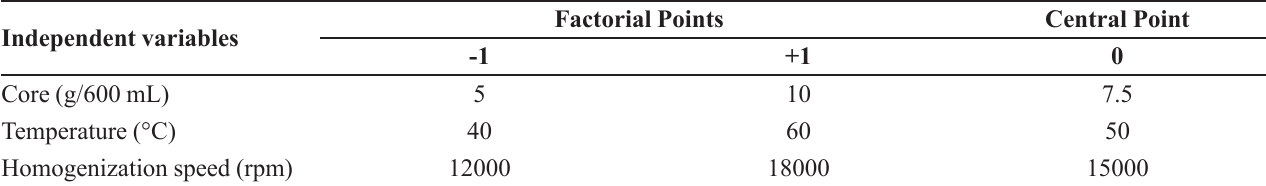
TABLE I - Factorial design 2 3 for obtaining microcapsules by complex coacervation of bacuri oil Independent